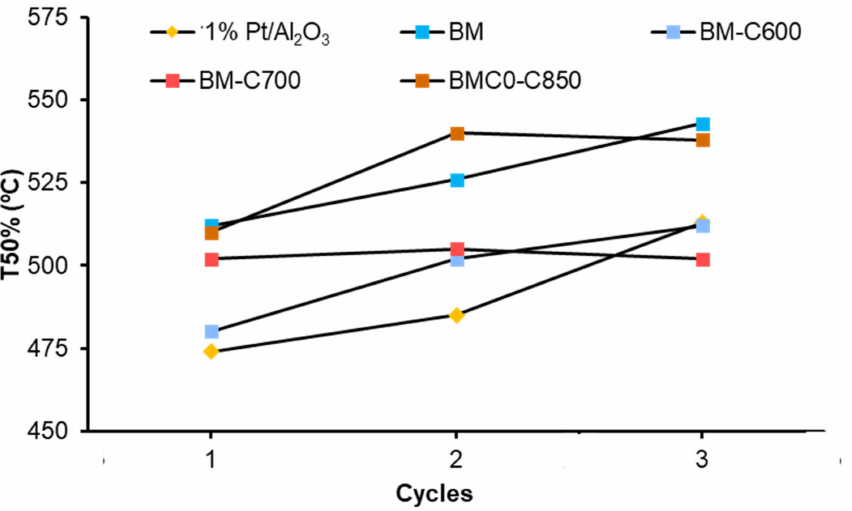
Figure 13. T50% values of BM-CX series, and references (1% Pt/Al 2 O 3 and BM), during consecutive NO x -TPR